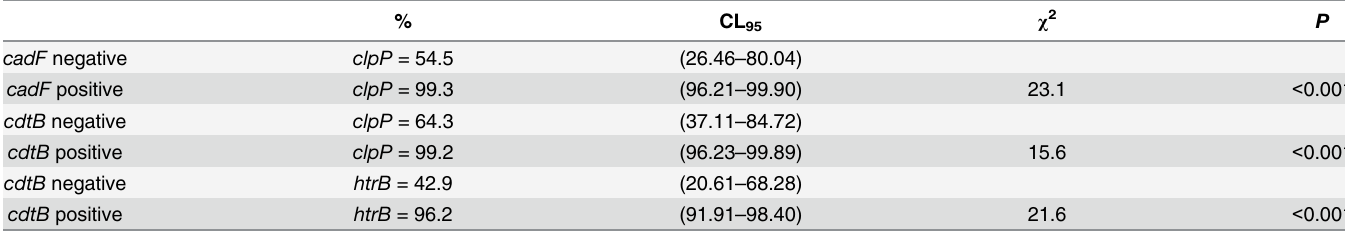
Table 3. Significant interactions among virulence factors in isolates that grew in Karmali medium ( n = 146).